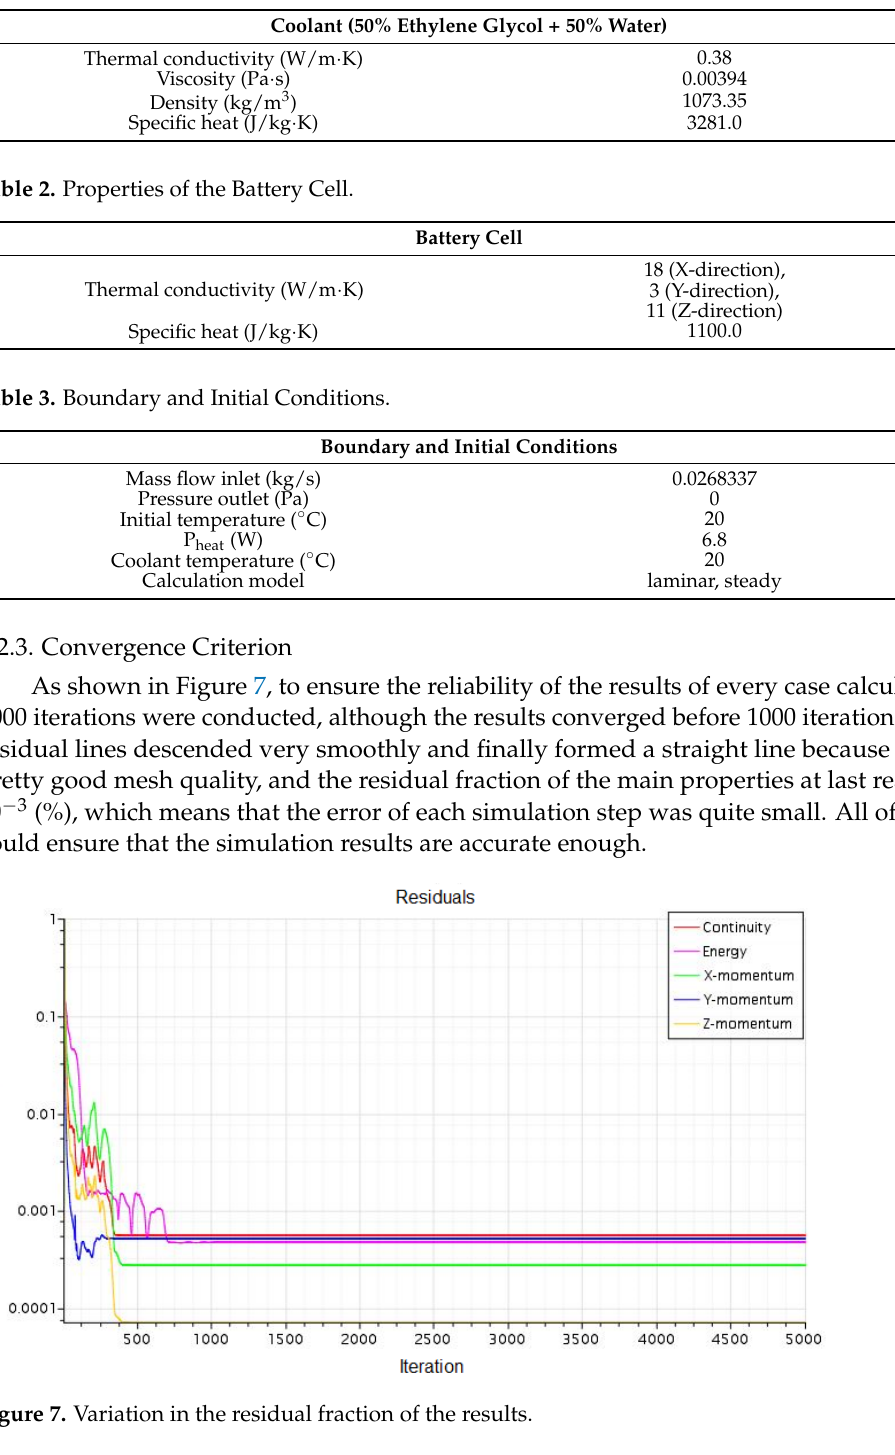
Table 1. Properties of the Coolant.